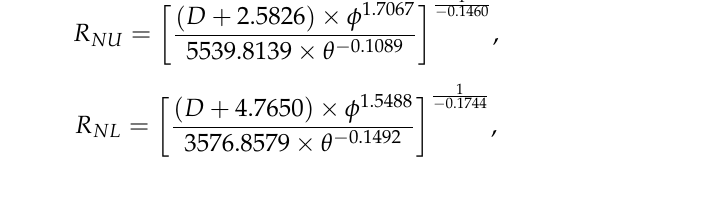
Figure 11. Prediction of rainfall distribution by linear analysis of 149 potential LSL areas.